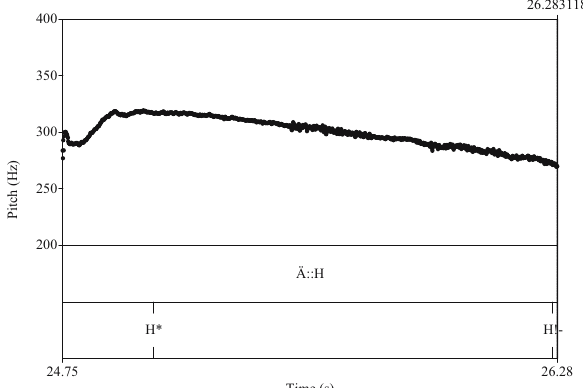
Figure 2: Ah - marker after racial utterance in excerpt